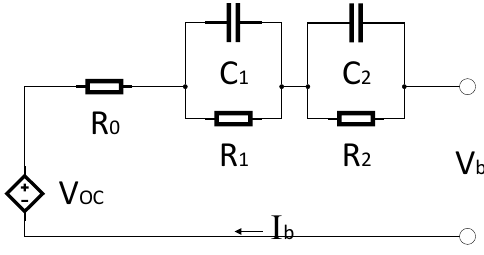
Figure 6. Equivalent circuit model of the battery.